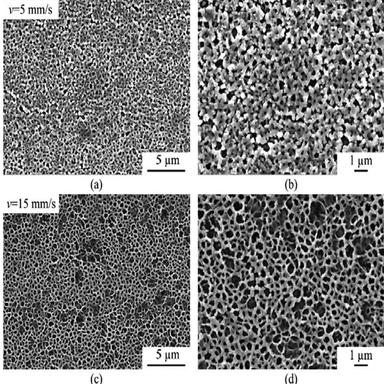
SEM morphologies of the multi-line scanned regions obtained under various scanning speeds (P = 1.48 W, f = 700 kHz, r = 76.6 %): (a) v = 5 mm/s, (c) v = 15 mm/s. (b) and (d) are the local enlarged images of Fig. 3(a) and (c), respectively.